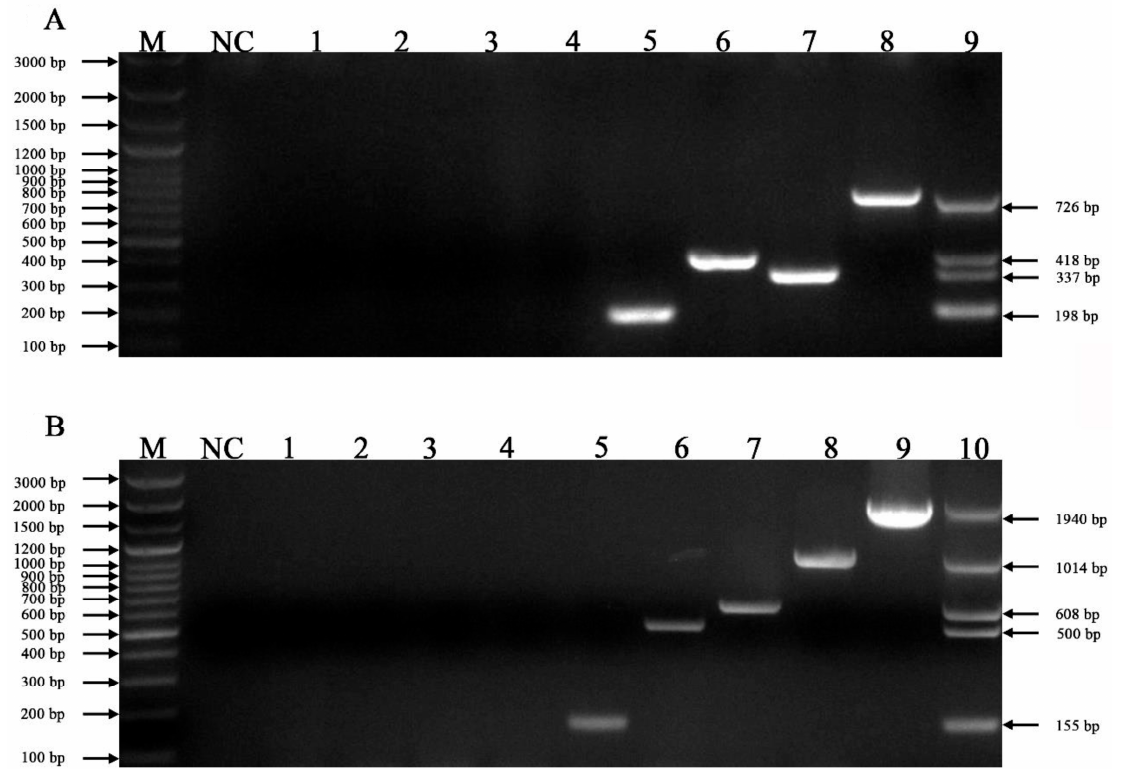
Figure 2. Specificity of the mPCR methods. ( A ) Lane M, DNA marker (100 bp ladder plus); lane NC, negative control; lane 1, F81; lane 2, Escherichia coli; lane 3, Salmonella enterica; lane 4, R rabies virus; lanes 5~8, 18-T-FeKoV, 18-T-FeAstV, 18-T-FPV and 18-T-FCoV, respectively; lane 9, mixed standard of 18T-FeKoV/ 18-T-FeAstV/ 18-T-FPV/ 18-T-FCoV plasmids. ( B ) Lane M, DNA marker (100 bp ladder plus); lane NC, negative control; lane 1, F81; lane 2, Escherichia coli; lane 3, Salmonella enterica; lane 4, rabies virus; lanes 5~9, 18-T-IAV, 18-T- C. felis , 18-T-FeLV, 18-T- FHV-1 and 18-T-FCV, respectively; lane 10, mixed standard 18-T-AIV/ 18-T- C. felis / 18-T-FeLV/ 18-T- FHV-1/ 18-T-FCV